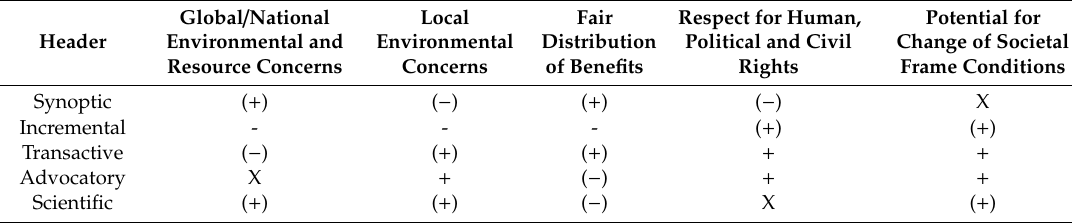
Table 1. Schematic overview of various planning